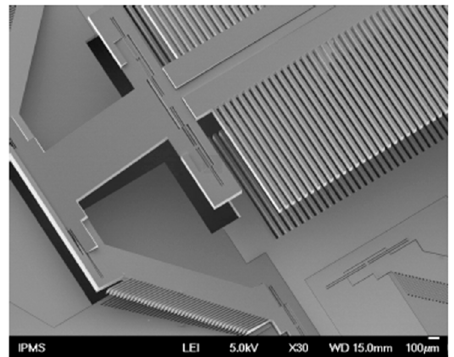
Figure 16. An electrostatic actuator for Lamellar grating based FTS: ( a ) FTS structure schematic: (1) Fixed fingers, (2) Movable fingers, (3) Rigid backbone, (4) Folded flexures; ( b ) fabricated MEMS device; ( c ) packaged device; ( d ) closed-up view of the serpentine flexure. (Reprinted with permission from References [39,40] IOP Publishing, Ltd.).